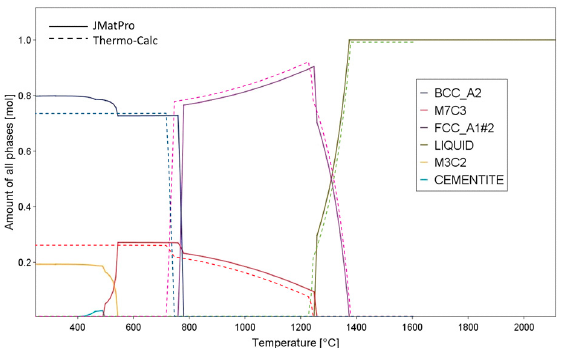
Figure 2. Dependence of phase fractions on temperature, as calculated with JMatPro and Thermo-Calc.